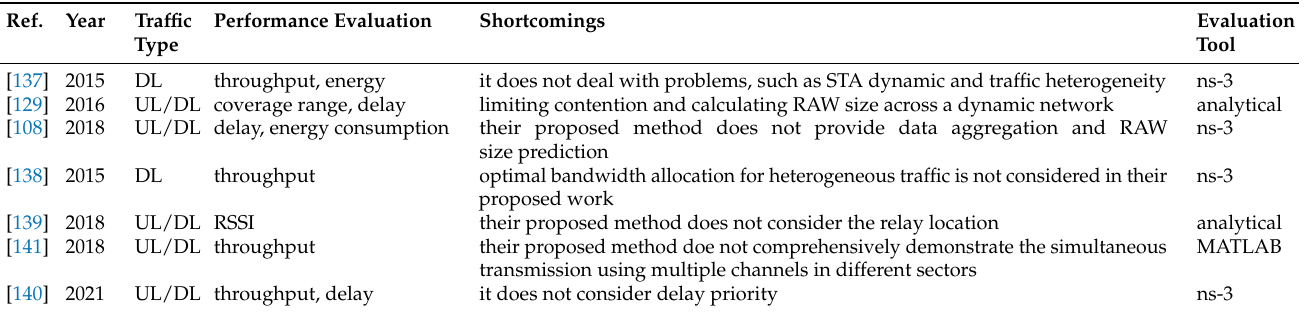
Table 7. Current solutions concerning relay and group sectorization in the IEEE 802.11ah WLAN with